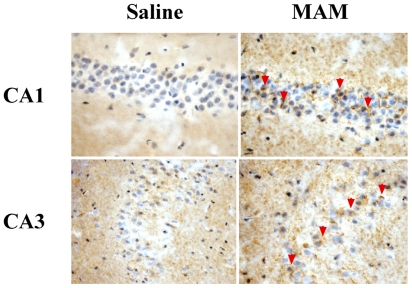
MAM induces Tau phosphorylation in the brain of htau mice. Neonatal (PND3) htau mice (mouse mutant that overexpresses normal human Tau) were given a single subcutaneous injection of saline or MAM (22 mg/kg). The hippocampus of the offspring was examined at post-natal day 90 for the phosphorylation of Tau at serine 199 (pS199). Note the heavy accumulation of pS199 within the axons (arrowheads) of CA1 and CA3 pyramidal neurons after MAM treatment. Tissue slides were prepared for immunohistochemistry according to Kisby et al. [83]. Magnification, x40 [images kindly provided by R. Woltjer (OHSU) and derived from unpublished data].